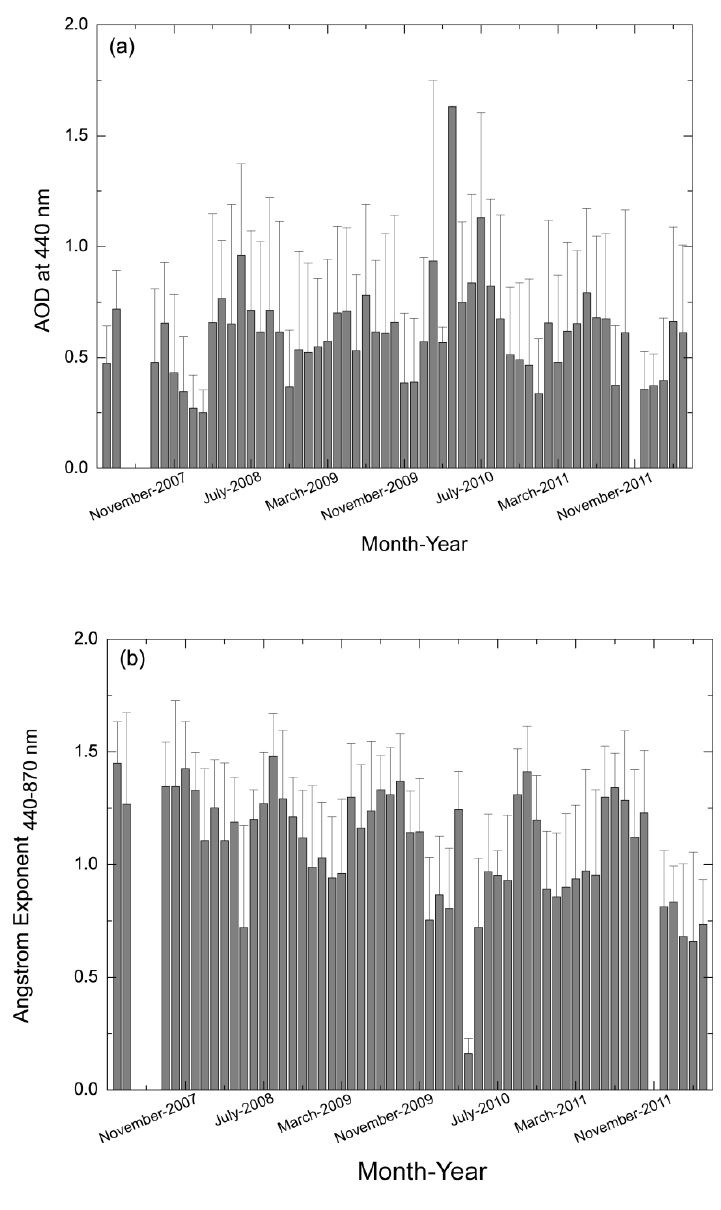
Figure 2. Annual variations with mean ± SD in the ( a ) AOD and ( b ) Ångström exponent at Dalian monitoring station.